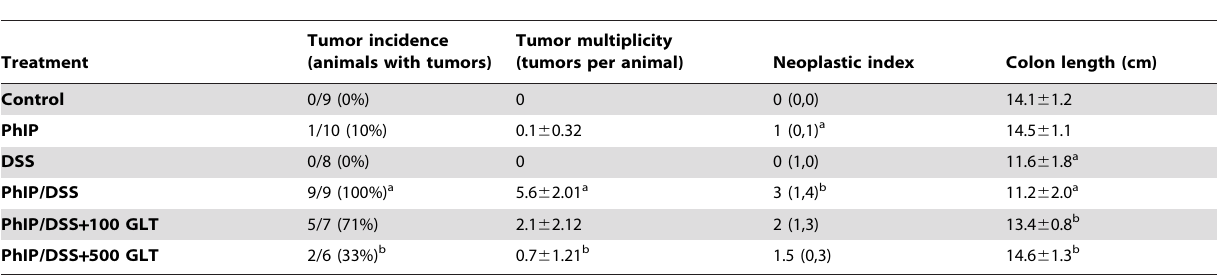
Table 1. Effect of GLT on the PhIP/DSS induced colon carcinogenesis and inflammation.